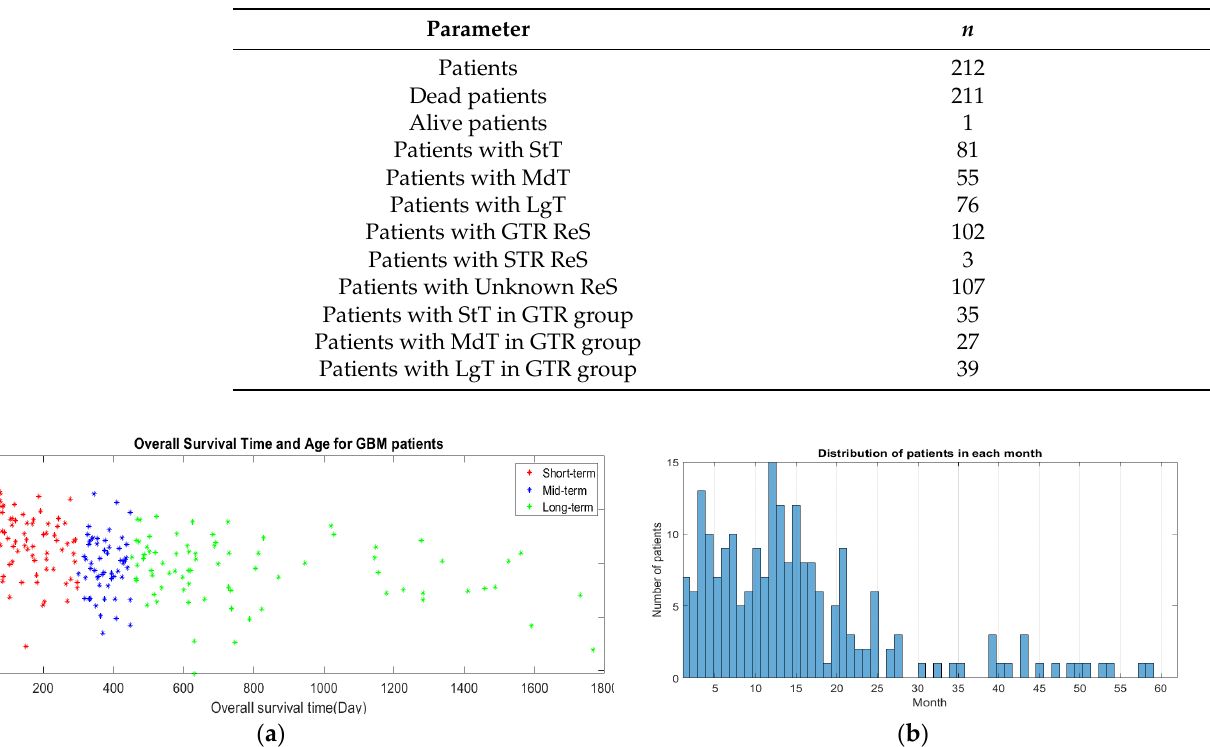
Figure 2. Multimodal MRI images based on 2D representation with segmentation labels (yellow: Ed, green: ET, red: NCR/NET) for a sample from the BraTS 2019 dataset-HGG group. ( a ) T1; ( b ) T2; ( c ) T1 Gd; ( d ) FLAIR; ( e ) labels. Table 2. Characteristics of the survival BraTS 2019 dataset. Resection status (ReS), short-term (StT), mid-term (MdT), long-term (LgT). Notes: the alive sample was discarded from the computations.